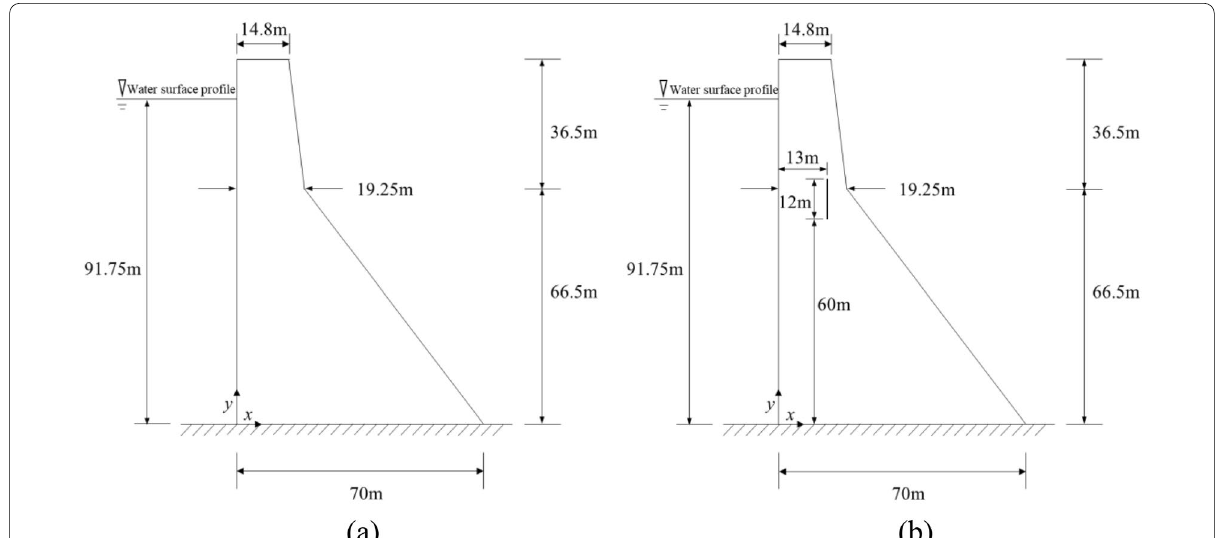
Fig. 22 Geometric dimensions of the Koyna gravity dams ( a ) without longitudinal crack and ( b ) with a penetrating longitudinal crack